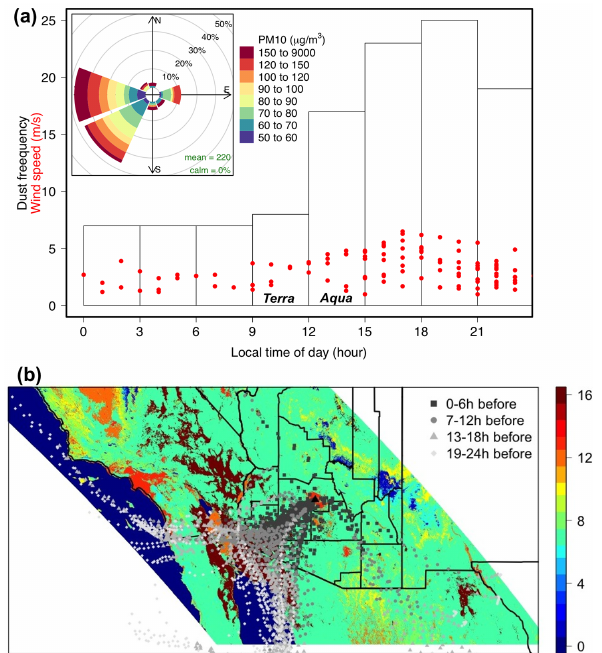
Figure 5. (a) Frequency of identified dust storms in Phoenix in 2007 as a function of the time of occurrence. Hourly mean wind speed ( ∼ half of the hourly maximum, with correlation coefficient of ∼ 0.93) during these dust storms is shown in red dots, and the inset panel shows the frequencies of PM10 within various con- centration intervals by wind direction during these dust storms. (b) Hourly HYSPLIT endpoints colored by four time intervals, overlaid on a 500m MODIS land cover type image. The MODIS land cover types mentioned in the text and their corresponding numbers are barren or sparsely vegetated: 16; urban and built-up: 13; open shrublands: 7; cropland: 12; and cropland/native vegeta- tion: 14 (source: https://lpdaac.usgs.gov/dataset_discovery/modis/ modis_products_table/mcd12q1).